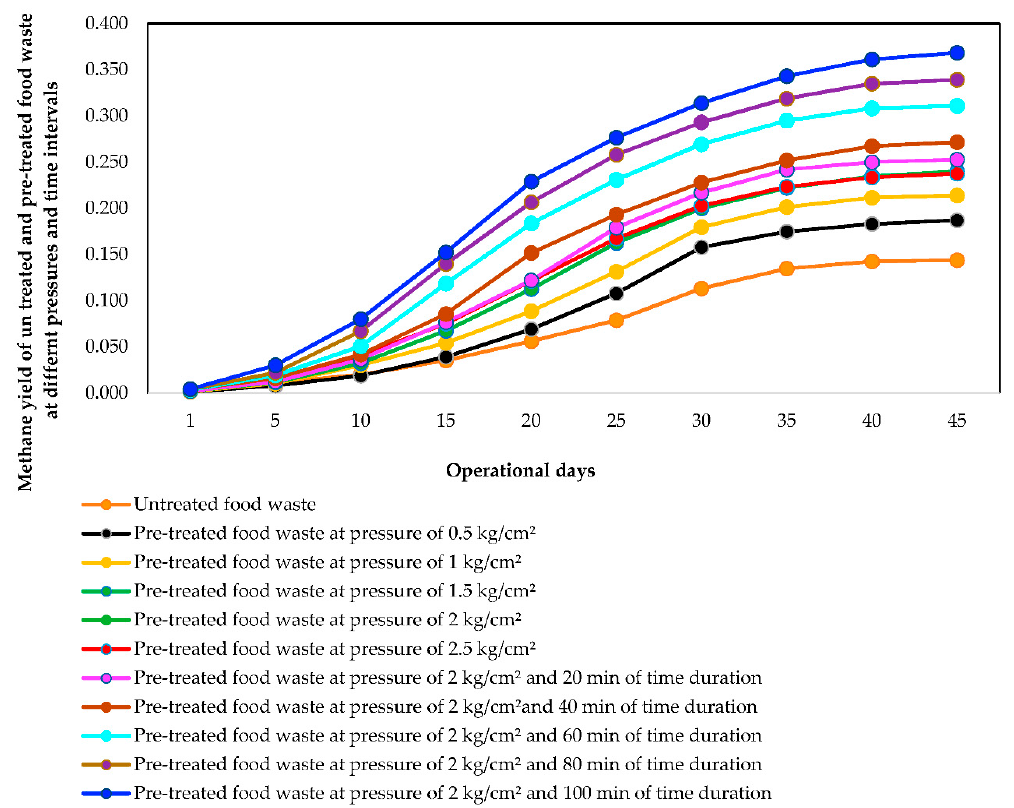
ff ect of pretreated food waste on batch residence time Figure 11. Effect of pretreated food waste on batch residence time (BRT). Figure 11. E